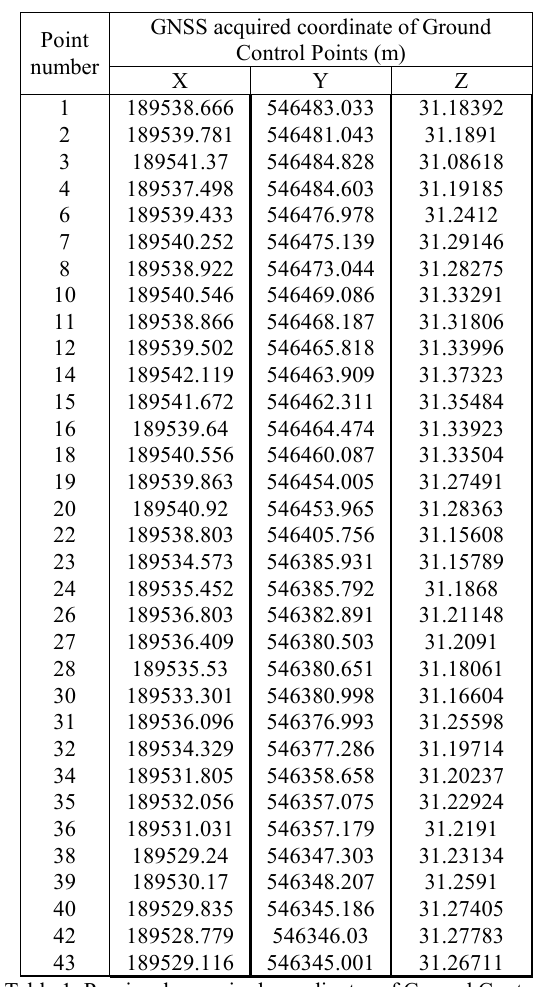
Table 1. Previously acquired coordinates of Ground